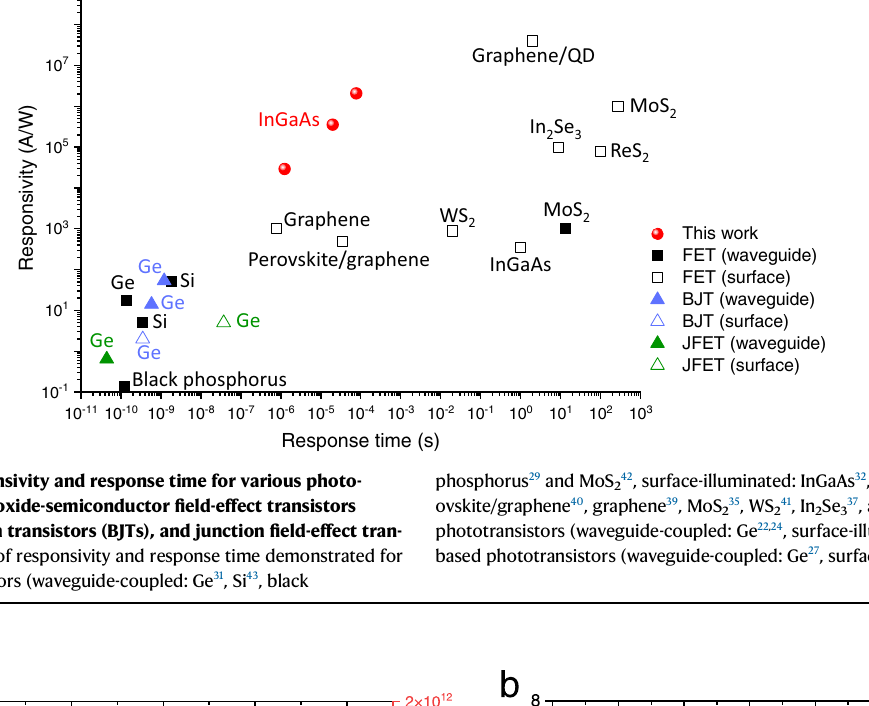
phosphorus 29 and MoS 2 42 , surface-illuminated: InGaAs 32 , graphene/QD 34 , per- ovskite/graphene 40 , graphene 39 , MoS 2 35 , WS 2 41 , In 2 Se 3 37 , and ReS 2 38 ), BJT-based phototransistors (waveguide-coupled: Ge 22,24 , surface-illuminated: Ge 25 ), and JFET- based phototransistors (waveguide-coupled: Ge 27 , surface-illuminated: Ge 28